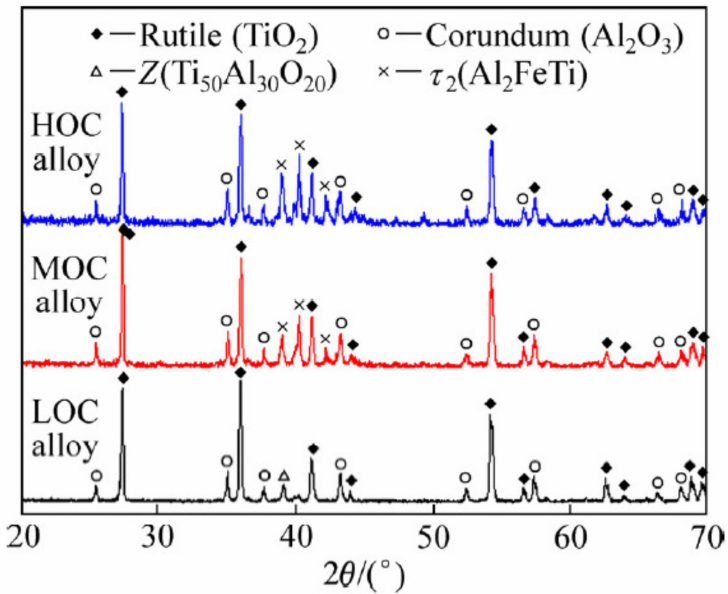
Figure 2. XRD patterns of oxide scales of oxidised low oxygen content (LOC) alloy, medium oxygen content (MOC) alloy, and high oxygen content (HOC) alloy. Reprinted from Transactions of Non- ferrous Metals Society of China, 29, Kun Zhao, Si-hui Ouyang, Yong Liu, Bin Liu, Xiao-peng Liang, Hui-zhong Li, Yu Wang, Isothermal oxidation behaviour of TiAl intermetallics with different